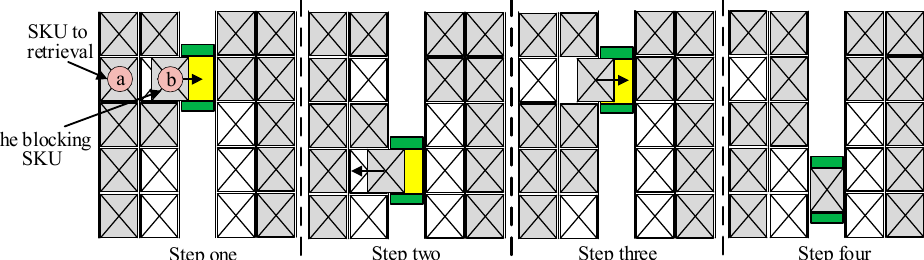
Figure 2. The procedure of the rearrangement of the blocking stock keeping units (SKU).